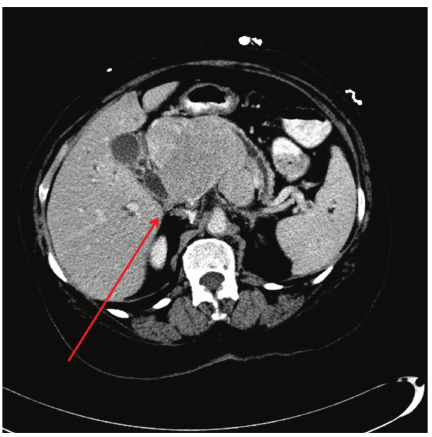
Figure 3: Contrast-enhanced axial CT image demonstrates a large homogeneously enhancing mass in the region of the pancreatic head which is causing compression of the distal common bile duct (red arrow).